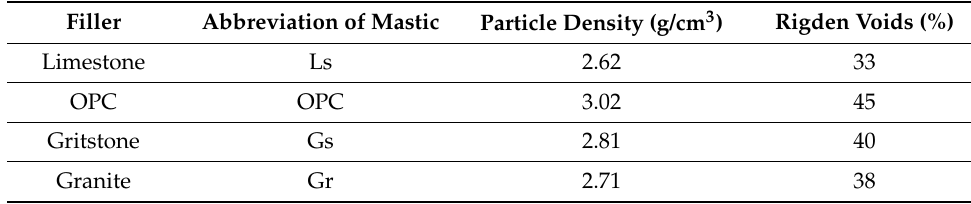
Table 2. Physical properties of fillers .